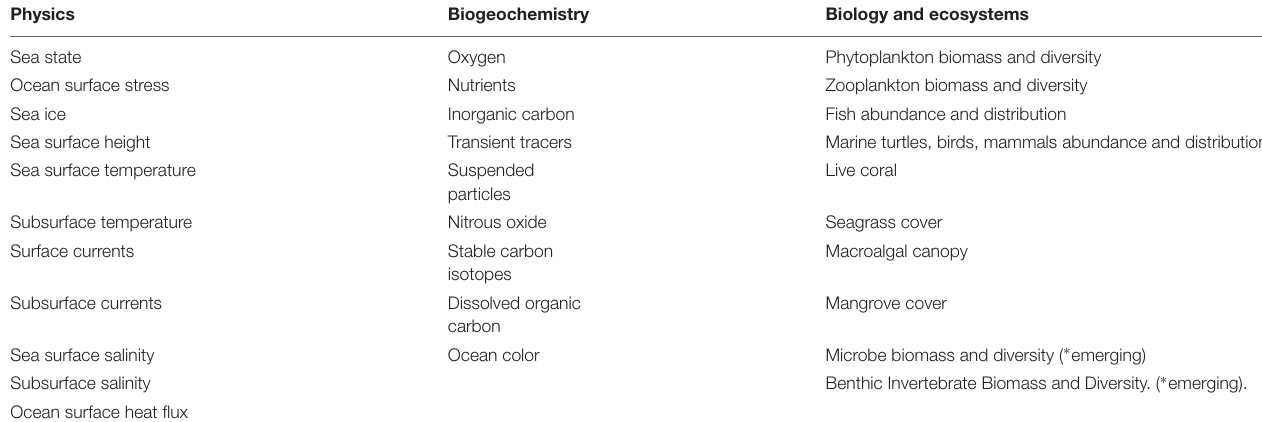
TABLE 1 | GOOS essential ocean